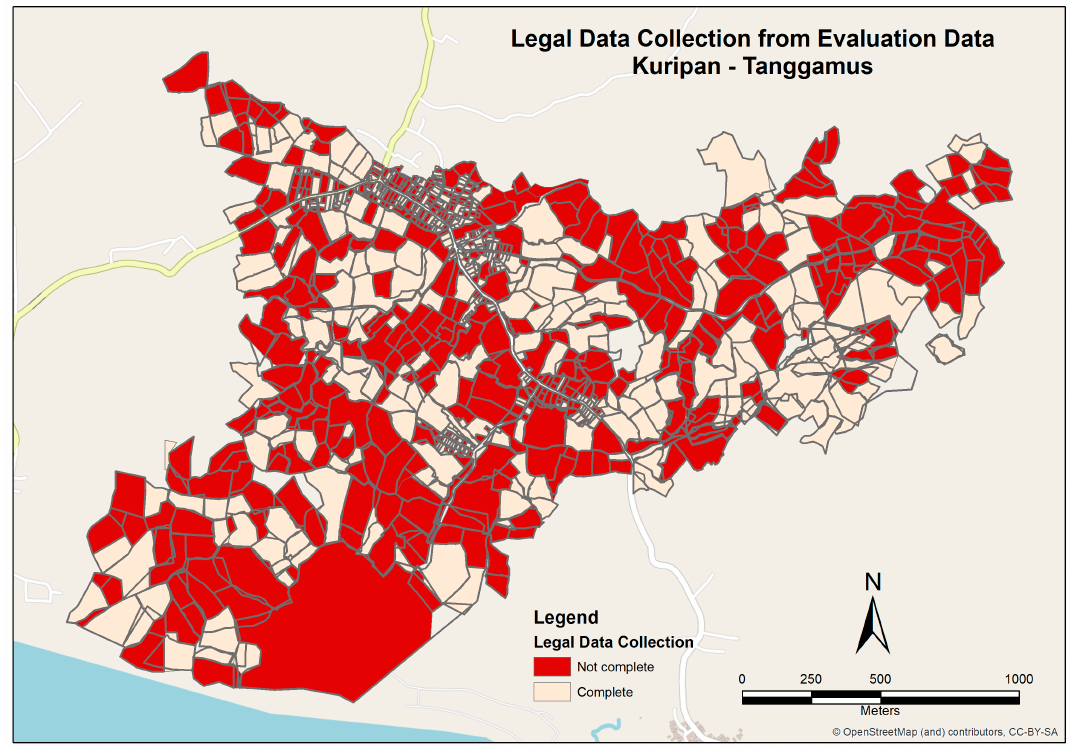
Figure 7. Completeness of legal collection in Tanggamus .